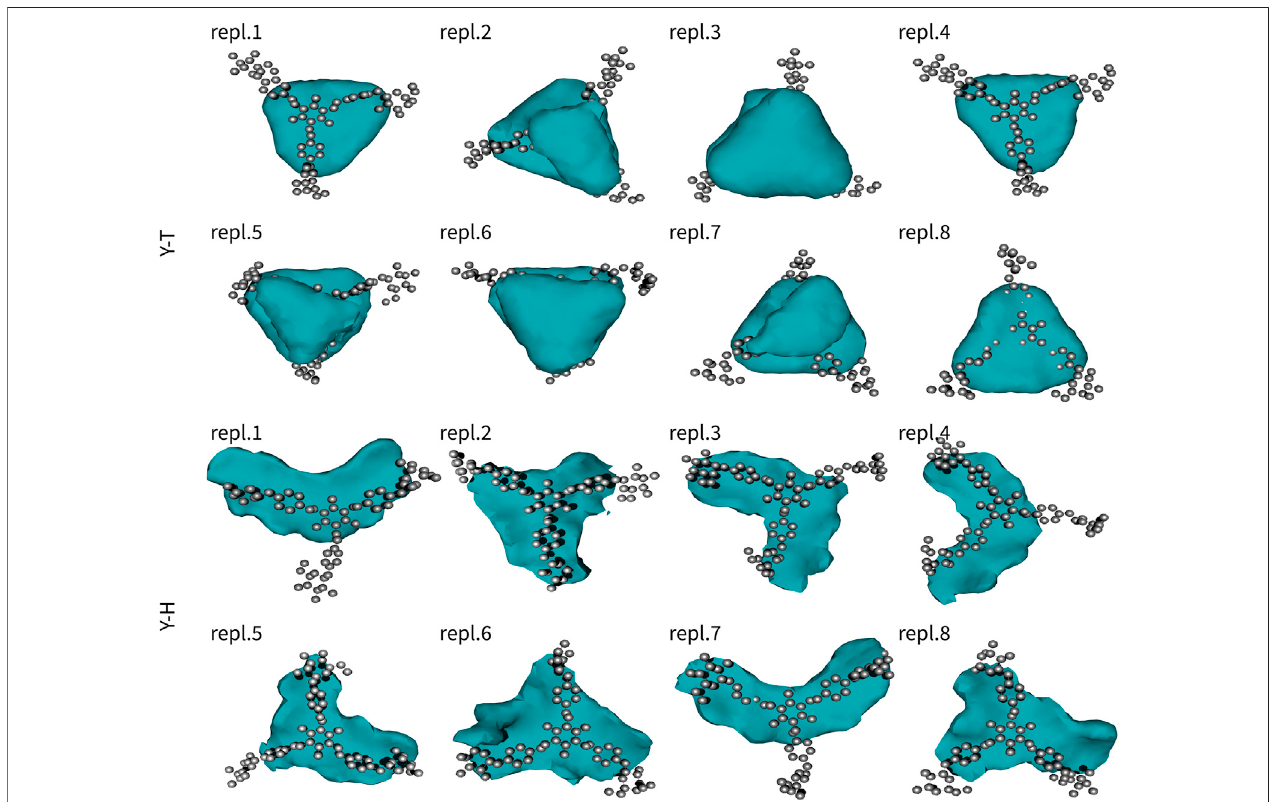
FIGURE 3 | Interactions ofYariv reagent with trisaccharide (YT) and hexasaccharide (YH). The molecule of Yariv was fi tted to the initial coordinates. Coordinates of the saccharide molecule were analysed in terms of a free-energy-like function. This function is depicted as isosurfaces at 5 kJ/mol (relative to the global minimum).